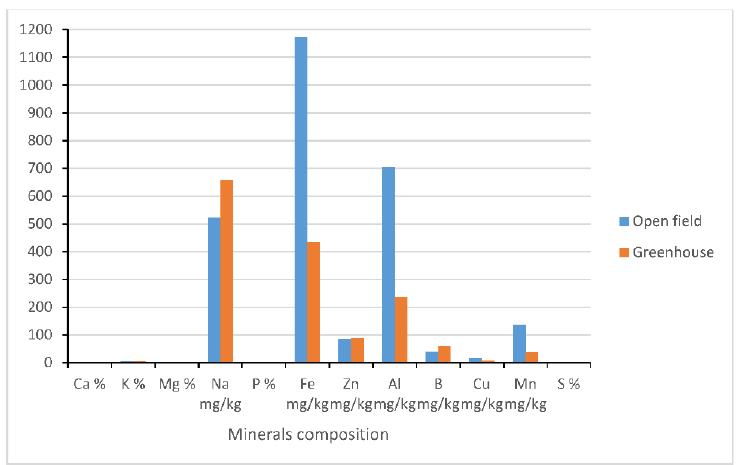
Figure 5. A comparative diagram showing the differences in mineral composition of A. Graecizans L. under open field (blue) versus greenhouse (orange) conditions, a referrer to open field whilst b referrers to greenhouse.